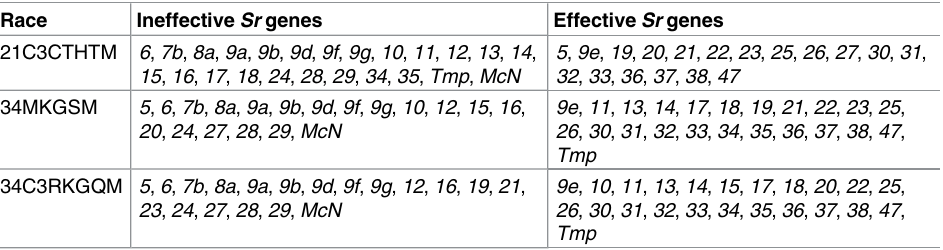
Table 1. Virulence/avirulence patterns of 3 races of Puccinia graminis f. sp. tritici